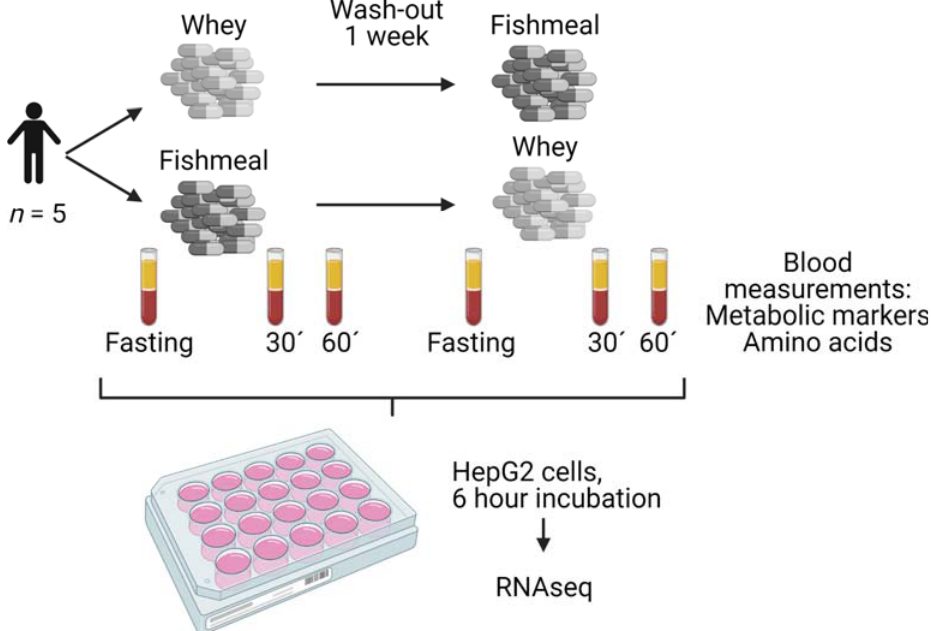
Figure 1. Experimental set-up. The study was a randomised, controlled, cross-over study on five healthy male participants. The participants were given 30 capsules containing a total of 5.2 g protein from salmon fishmeal and whey, separated by a 1 week washout period. Blood samples were taken before (fasting) and 30 and 60 min after intake. The effects of fishmeal and whey on metabolic markers and serum amino acid concentrations were measured. Cultured HepG2 cells were incubated for 6 h in serum-free medium or with 20% human serum from all time points. The response in gene expression was measured with RNA sequencing. The figure was created with BioRender.com.